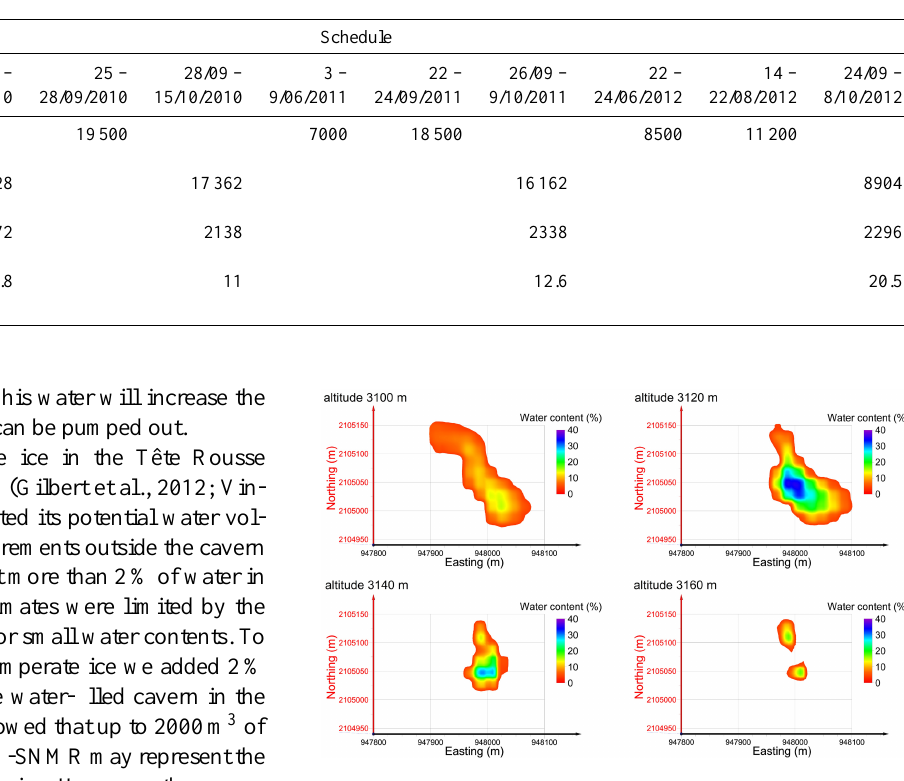
Table 1. Summary of measurements of the water volume accumulated in the central cavern using 3-D-SNMR and pumping.